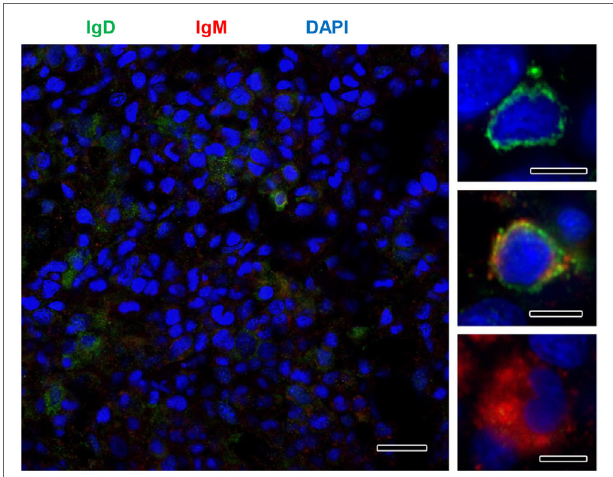
FigUre 3 | IgM and IgD detection in rainbow trout kidney infected with Tetracapsuloides bryosalmonae. IgD (green) and IgM (red) were immunolabeled in grade 2 kidney sections and counterstained with DAPI (blue). Details show the presence of immunoreactive IgD + /IgM − , IgD + /IgM + , and IgD − /IgM + B cells. Scale bar in left hand image = 20 µm; scale bars in right hand images = 5